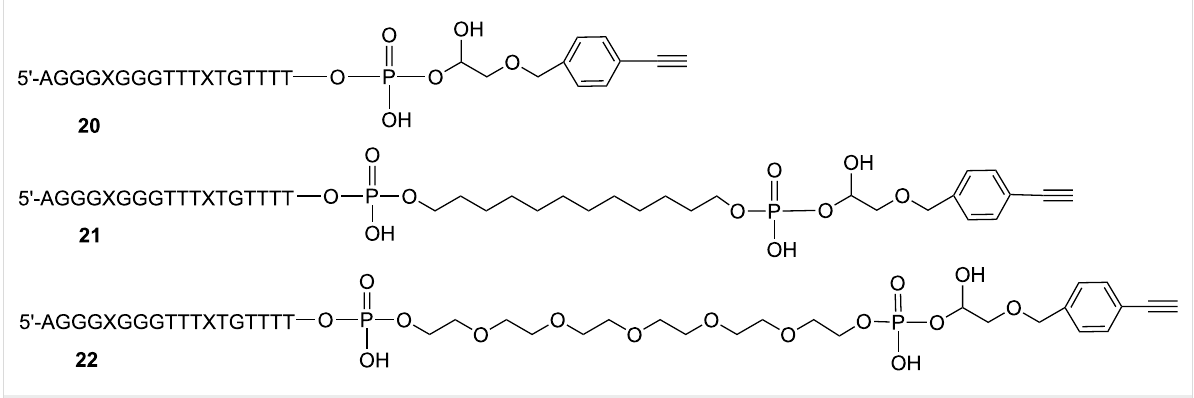
Figure 11: TINA-TFOs bearing a 3'-alkyne group for antiparallel triplex formation with the target HIV proviral DNA (Figure 4).